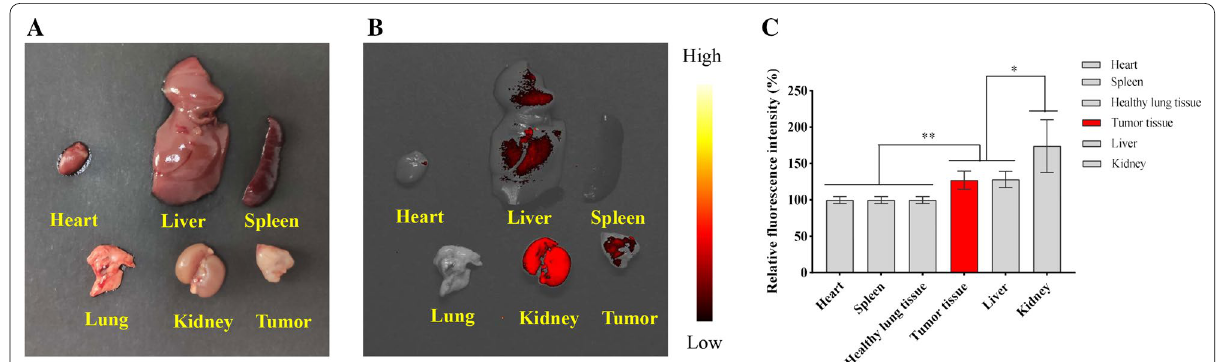
Fig. 6 a Bright photograph of the heart, liver, spleen, lung, kidney, and tumor in Si QD micelles-CKAP4 injected mice. b Fluorescence photograph of the heart, liver, spleen, lung, kidney, and tumor in Si QD micelles-CKAP4 injected mice. c Relative fluorescence intensities of heart, liver, spleen, lung, kidney and tumor tissue ( n 3; mean SD; one-way ANOVA with Dunnett’s post test; * P < 0.05; ** P < = ±